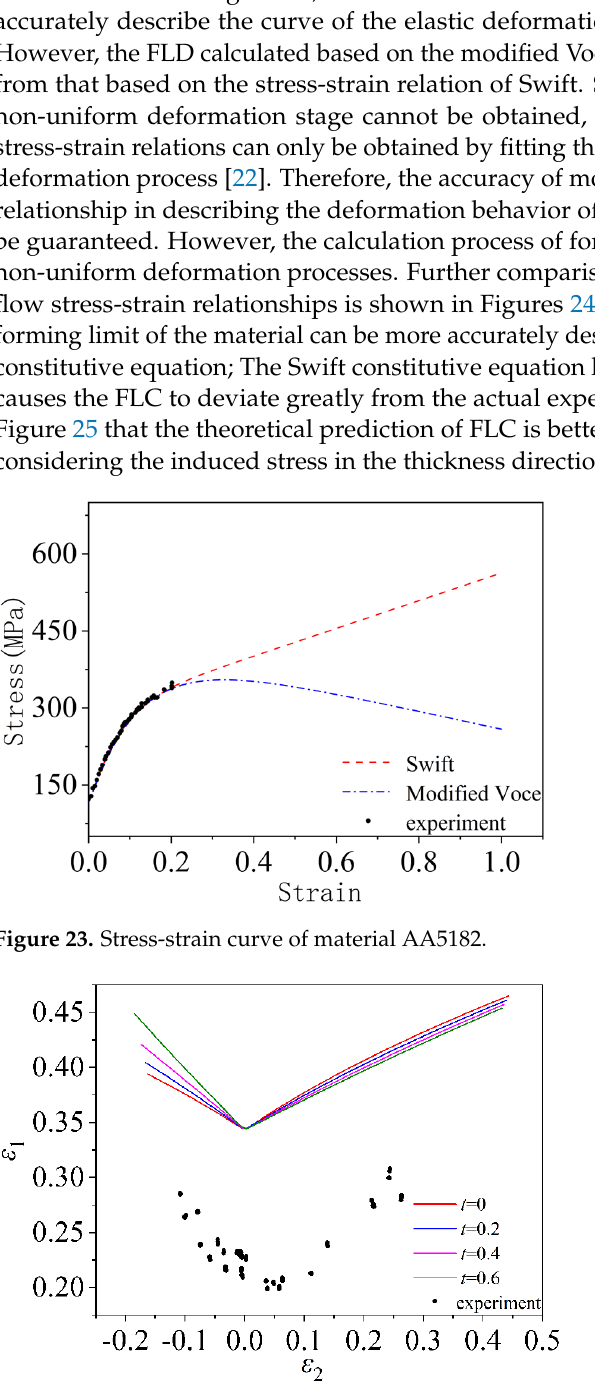
Figure 25. FLD of material AA5182 based on modified VOCE constitutive equation and MMFC in- stability criterion. 5.3. Forming Curve Verification of Material 5754O The mechanical properties of the material 5754O are shown in Table 7. Table 7. Mechanical properties of material 5754O.